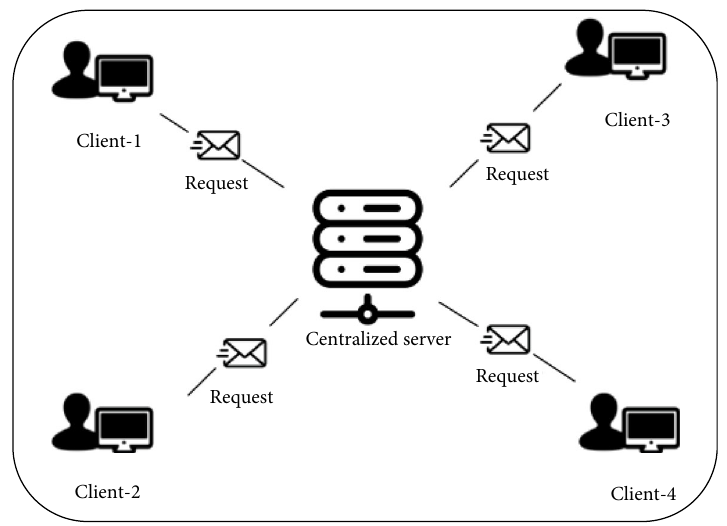
Figure 1: Centralized application architecture.